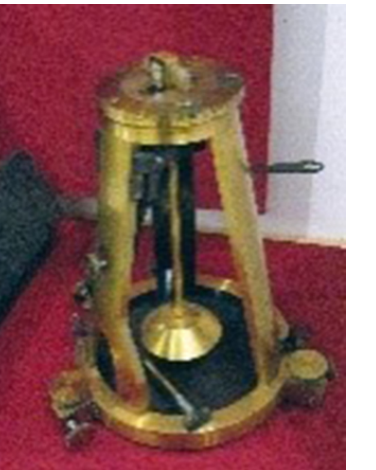
Figure 1. A Sterneck pendulum acquired in 1892, on display in the museum of the Norwegian Mapping Authority.